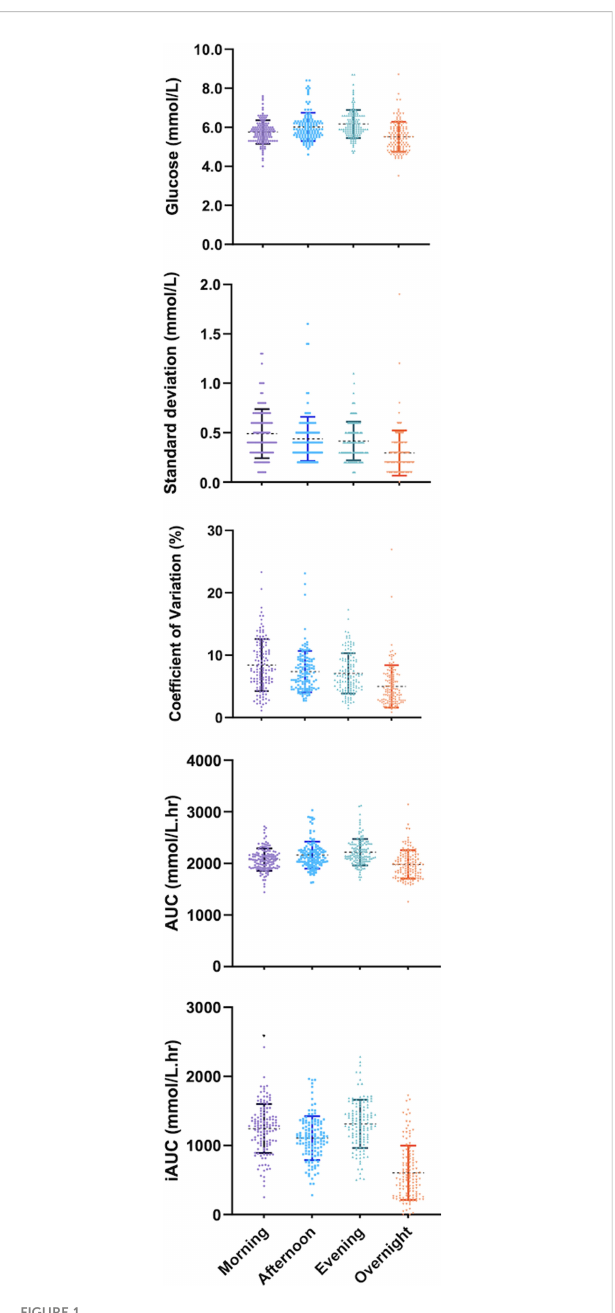
FIGURE 1 Mean 7-day measures of continuous glucose monitoring (CGM) across periods of a day for 128 women with